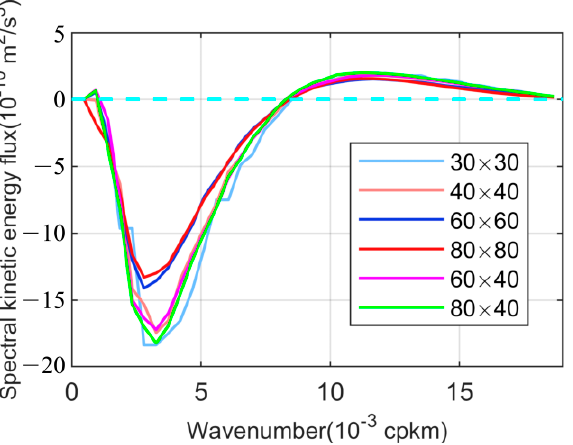
Figure 1. Spectral kinetic-energy fluxes on rectangular domain centered on 22° N, 165° E with different sizes (30 × 30, 40 × 40, 60 × 60, 80 × 80, 80 × 40, 60 × 40 grid points). Only taking Π A definition as an example, and the fluxes are based on the surface velocity of ECCO2 model without data